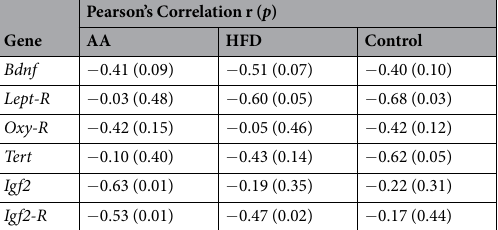
Table 5. Results from the correlational analysis carried out between promoter methylation and expression level for each of the genes of